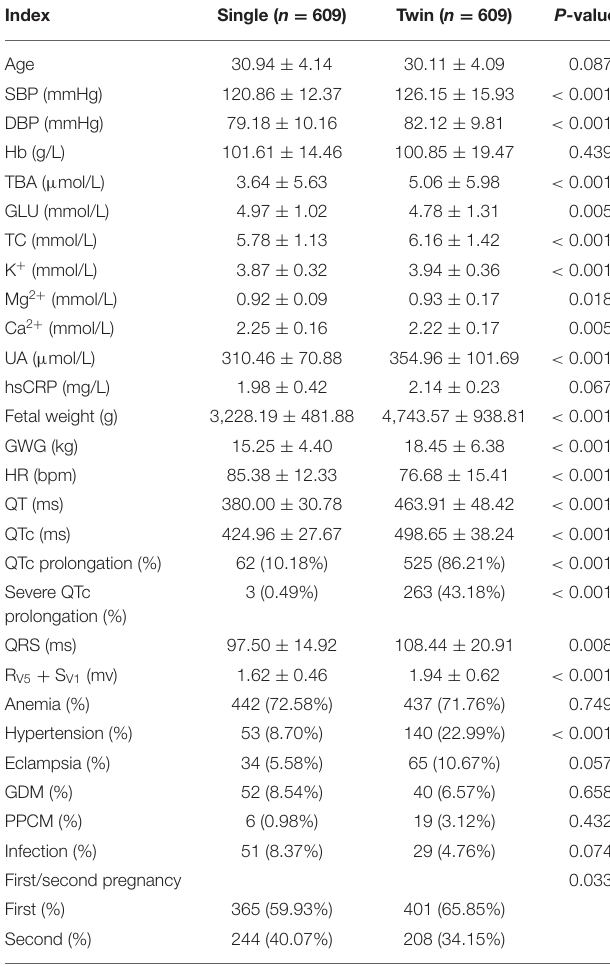
TABLE 1 | Compared of demographic and clinical characteristics between single and twin